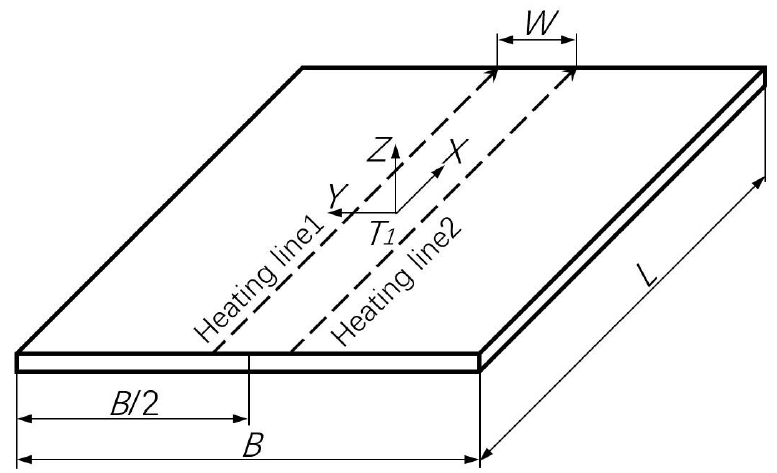
Figure 19. Parallel heating diagram ( L C /B = 0.10).